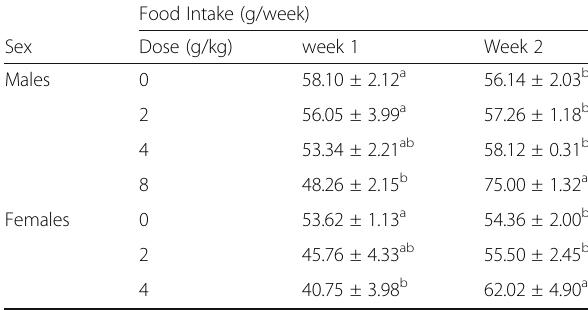
Tabulated values are mean ± SEM of five trials. Values of the same column with different letters are significantly different at P <